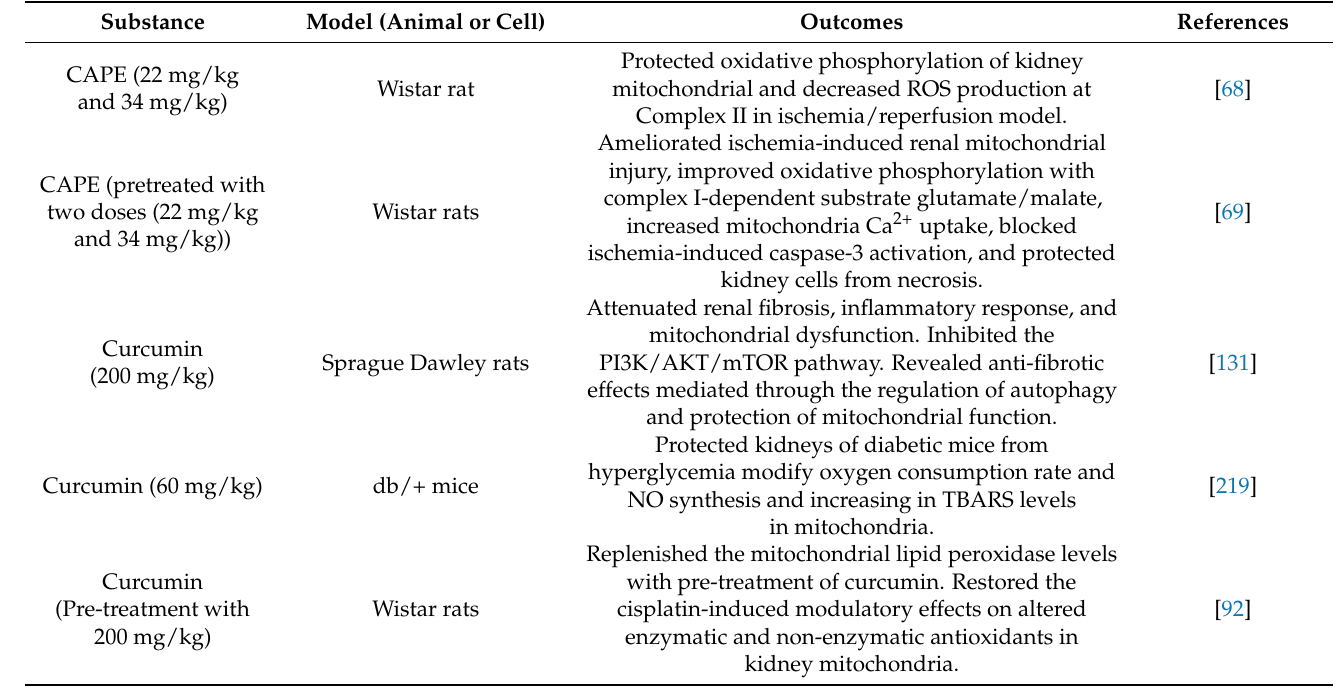
Figure 2. Polyphenols and their roles in renal mitochondrial dysfunction. Polyphenols regulate mitochondria biogenesis and dynamics via increasing Nrf2 and PGC-1 α expression and balancing fission and fusion events, while kidney diseases result from imbalanced mitochondria dynamics and reduce biogenesis. In this pathway, deacetylation of SIRT and phosphorylation of AMPK can positively regulate biogenesis. Polyphenols can decrease the protein levels of pro-inflammatory factors, including TNF- α , IL-1 β , IL-6, and NF- κ B to exert anti-inflammatory effects. They also improve mitochondria function and injury through inhibition of ROS generation. Polyphenols show protective effects through inhibiting MPT pore opening, which can trigger the release of cytochrome C into the cytosol, swelling of mitochondria, and activating of caspase cascade; finally, they reveal anti-apoptotic impacts. Further, polyphenols restore antioxidant enzyme levels such as SOD2 and CAT to normal levels, improve antioxidant status, and scavenge free radicals. Table 1. Preclinical evidence of polyphenols as a therapeutic approach for kidney disease.